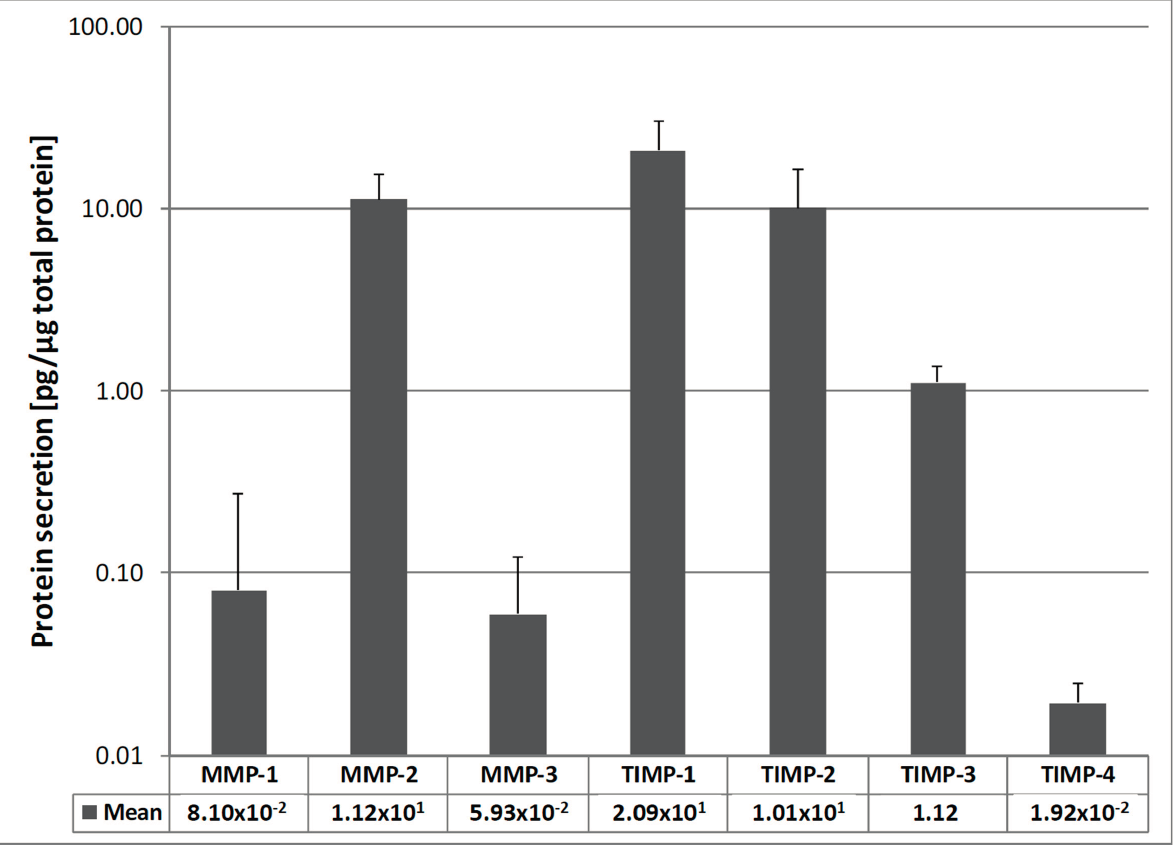
Figure 2. MMP and TIMP protein secretion of all samples. MMP-2 and TIMP-1 data were derived from sandwich ELISA. All other proteins were analyzed using Multiplex ELISA technique. All values were normalized to the total protein content (Coomassie Plus assay), given as mean ± SD ( n = 30) represented in a logarithmic graph. MMP-2, TIMP-1, and -2 protein secretion was strongest in the cells, while MMP-1, -3, and TIMP-4 protein secretion was